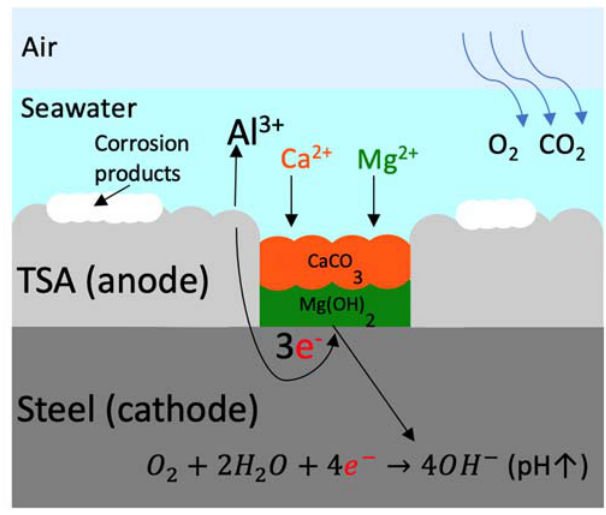
Figure 2. Sacrificial protection mechanisms provided by Al coatings 74